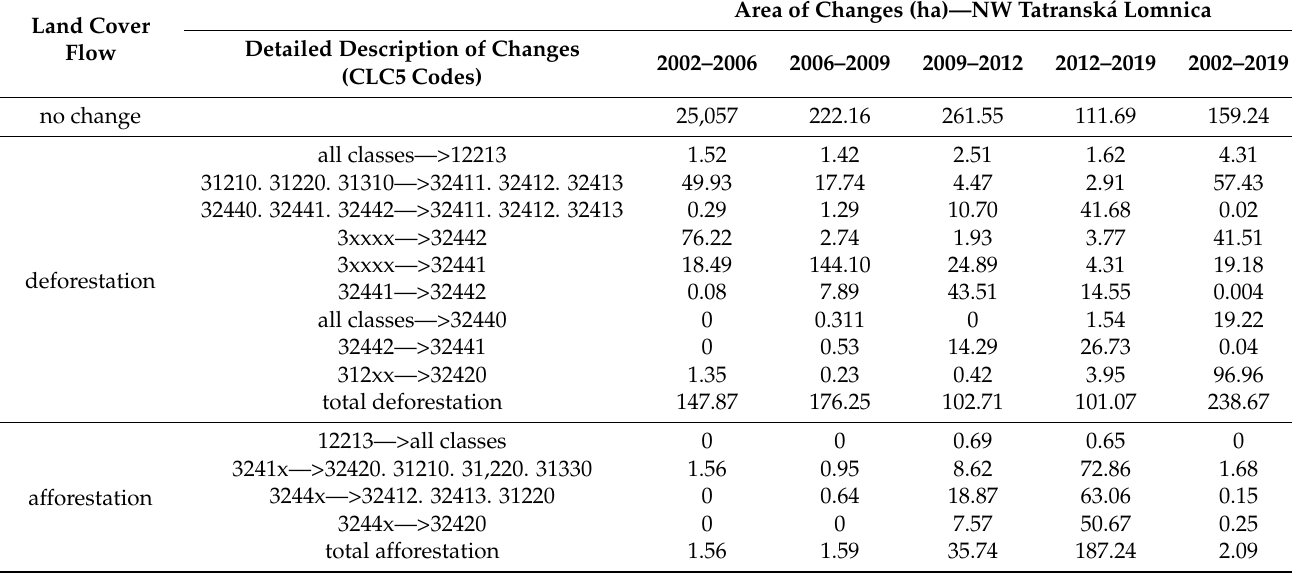
Table 6. Flows of land cover changes in the area NW from Tatransk á Lomnica (TANAP). Land Cover